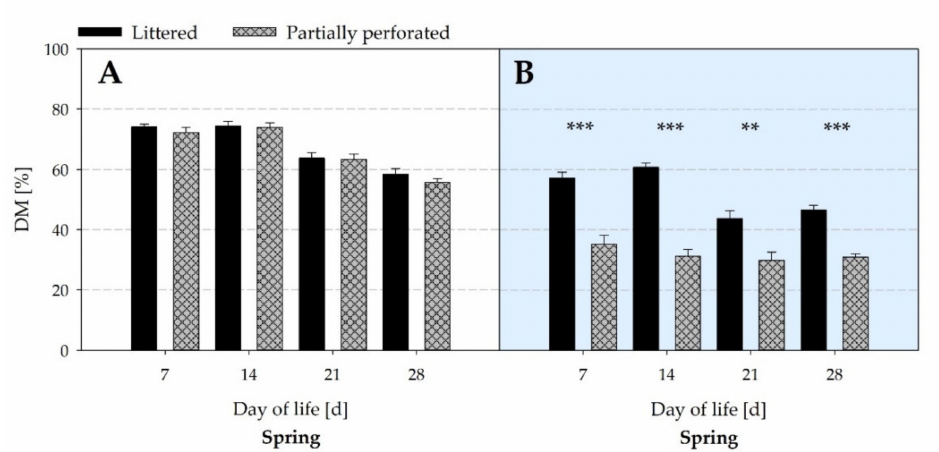
Figure 10. Average dry matter (DM) contents of litter samples from ( A ) the littered side areas and ( B ) the supply area ( n = 6 values per day and barn in area ( A ); n = 3 values per day and barn in area ( B )) from broiler houses with two different floor types measured over the spring fattening period. Significant differences are marked by asterisks: ** p < 0.01, *** p <